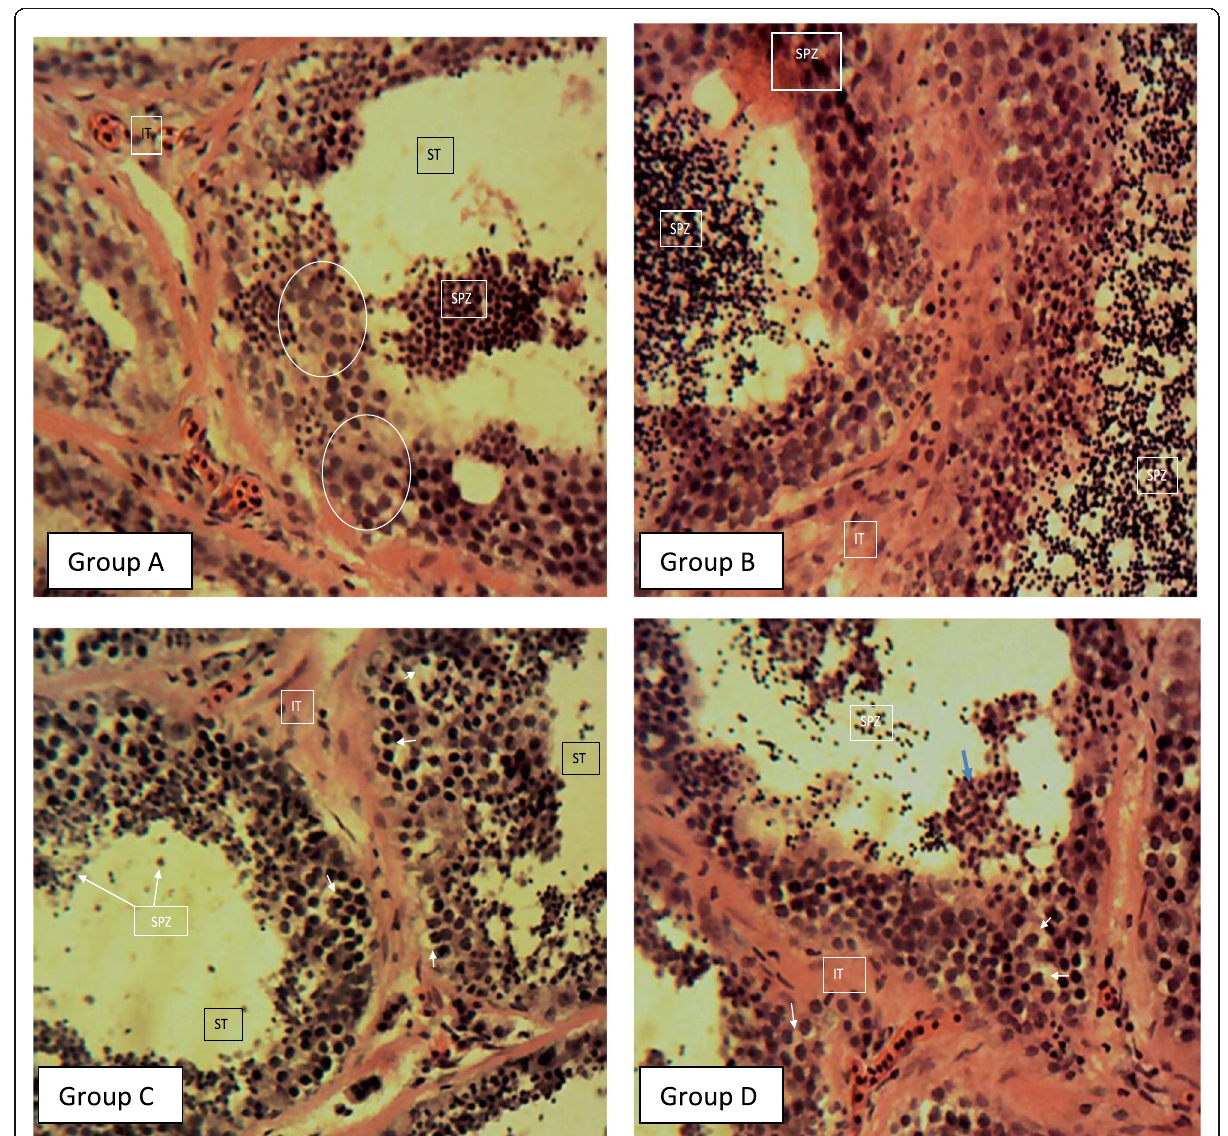
Fig. 4 Histopathology of the testes of C. gariepinus exposed to different concentration of lambda-cyhalothrin on day 28. Group A (control), B (2.5 × 10 − 4 μ g/L), C (5.0 × 10 − 4 μ g/L), and D (6.25 × 10 − 4 μ g/L) (seminiferous tubule (ST), spermatocyst (white circle), testicular interstitium (IT), and spermatozoa (SPZ) H&E ×